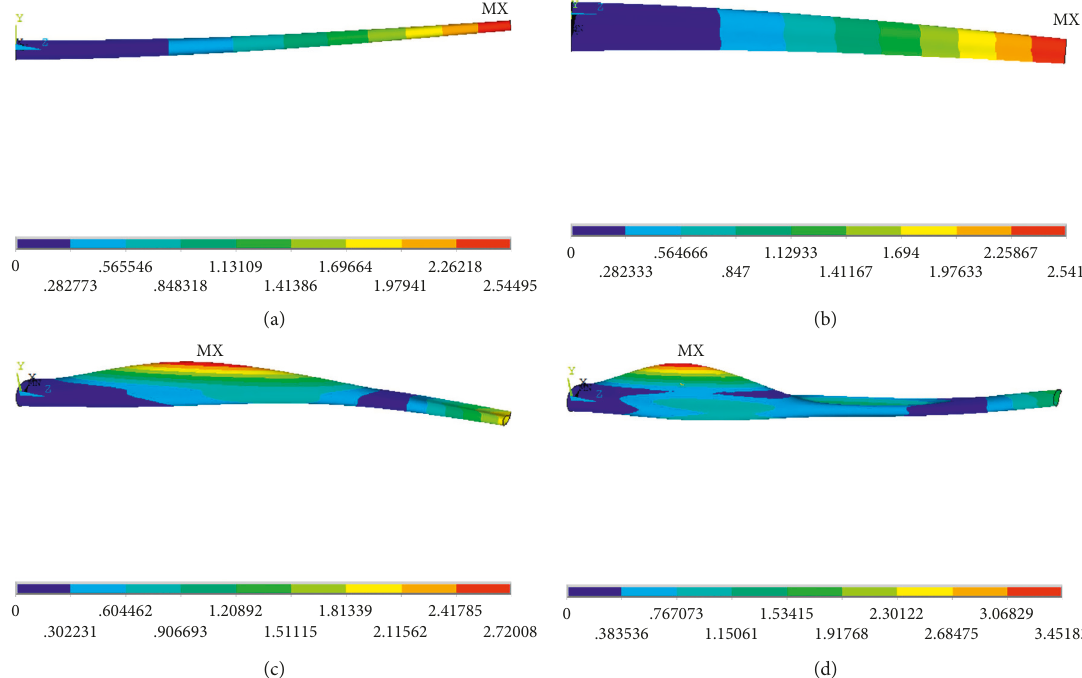
Figure 7: The first four mode shapes of the tapered wind turbine blade using ANSYS. (a) First mode shape. (b) Second mode shape. (c) Third mode shape. (d) Fourth mode